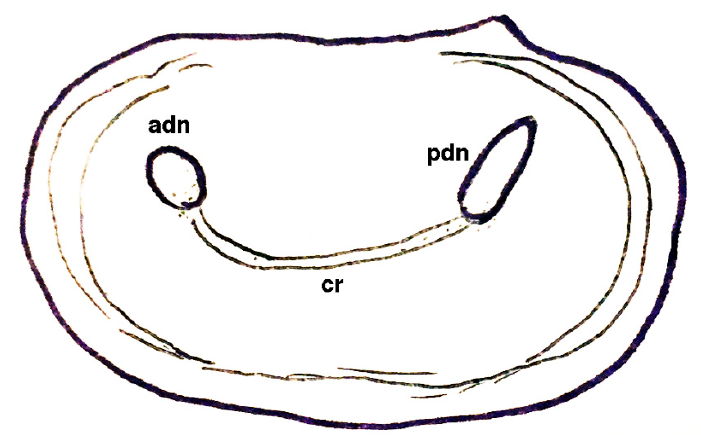
Figure 12. Cordubiella pedrochensis . Anterior to left. Length of shield 5.1 mm. Abbreviations: adn , anterodorsal node; cr , connecting ridge; pdn , posterodorsal node. Image Credit: Mark McMenamin. Dictyocharion Jones & Kruse 2009 [58]; Hipponicharionidae; Range: Middle